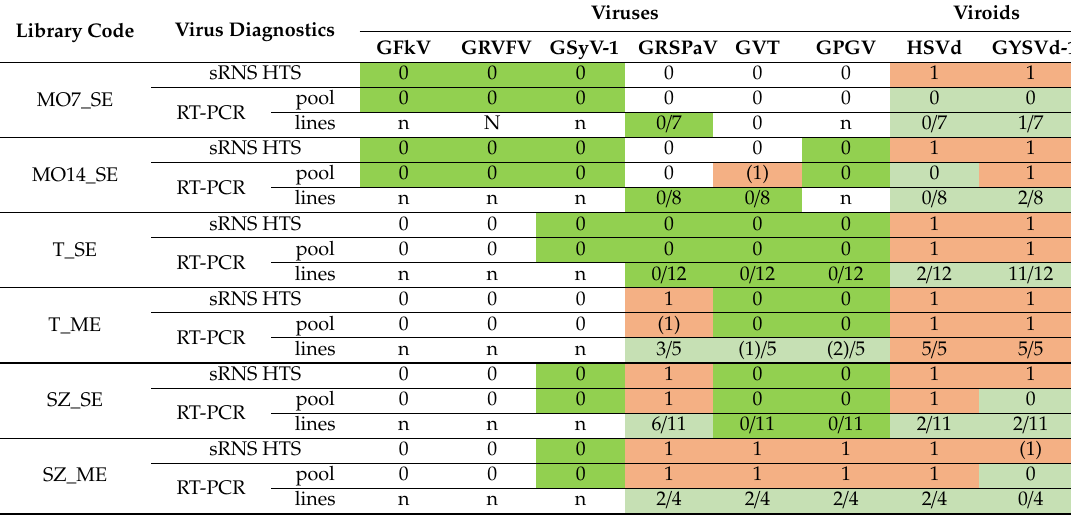
Table 5. Summary of the results of the virus elimination e ffi ciency of SE and